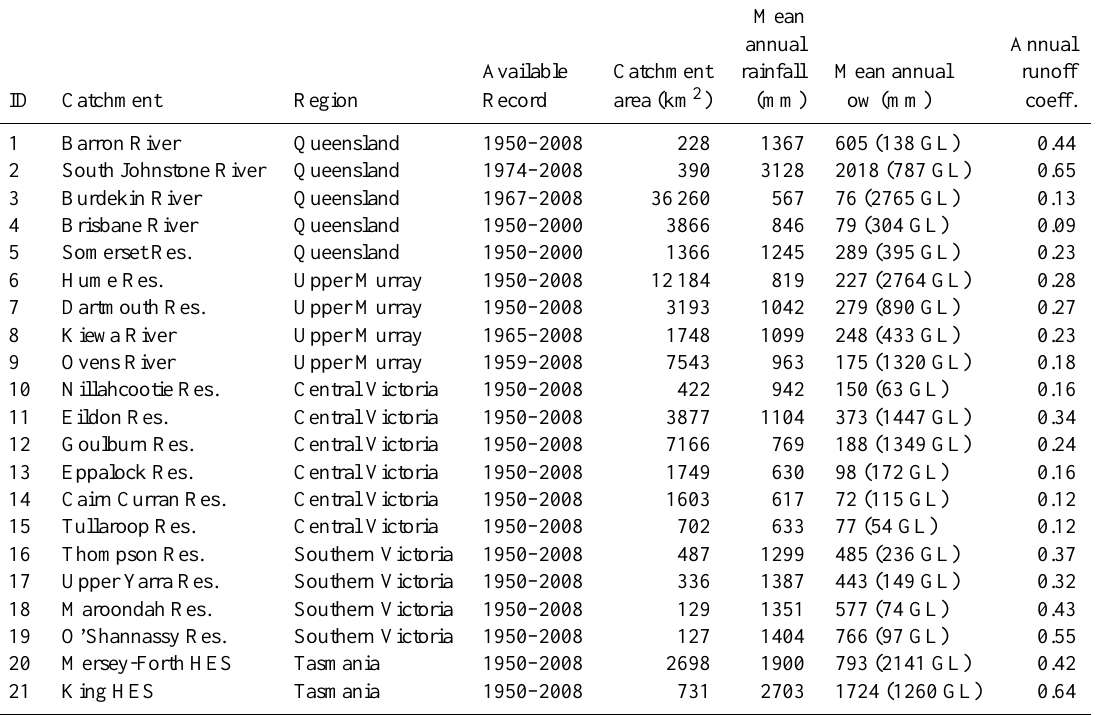
Table 1. Attributes of the 21 catchments used for the study. (Res. indicates Reservoir inflow, HES indicates inflow to hydroelectric scheme).